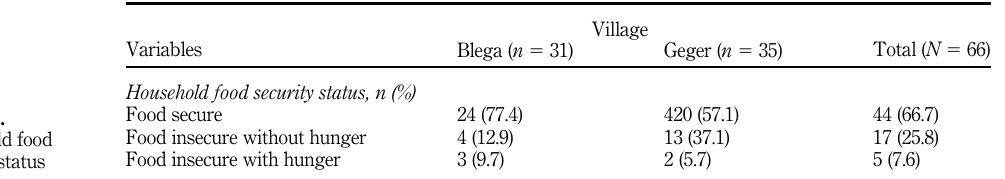
Table I. Household characteristics